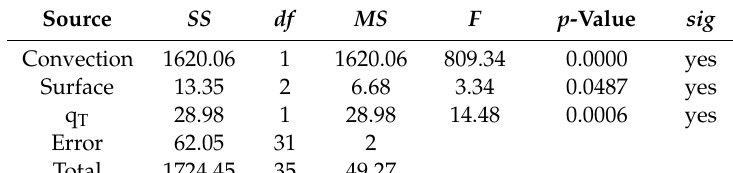
Table 11. Results of ANOVA for convective heat transfer coefficient.